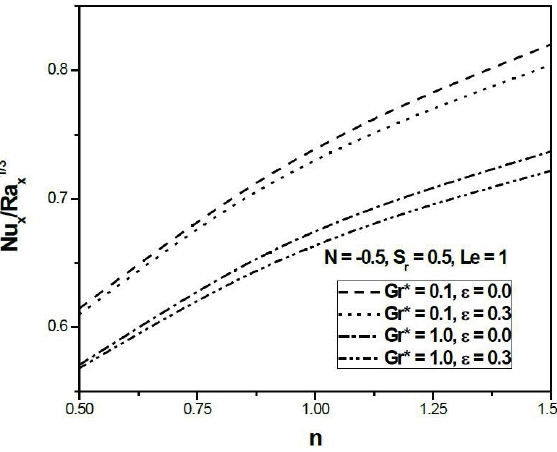
Fig. 9: Variation of mass transfer coefficient against n (Opposing